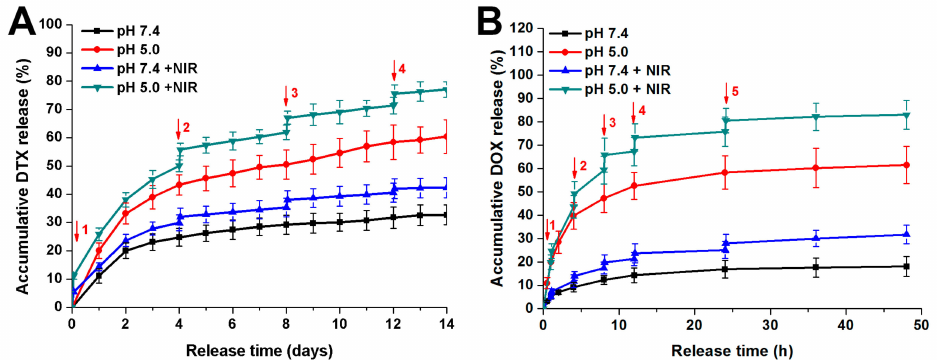
Figure 4. In vitro drug release profiles of DTX / NPs@PDA / DOX-PEG-Apt at di ff erent pH with or without NIR laser irradiation (808 nm, 1.5 W / cm 2 ). ( A ) Accumulative DTX release. ( B ) Accumulative DOX release. ↓ : NIR irradiation for 5